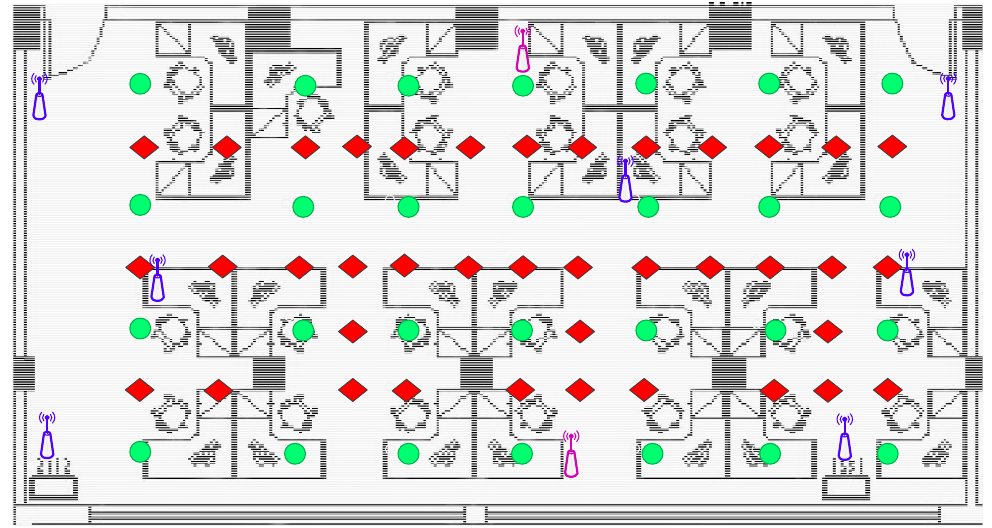
Figure 5. Experiment settings for indoor positioning: The green, circular symbols represent reference points (RPs), and the red, diamond symbols represent test points (TPs).